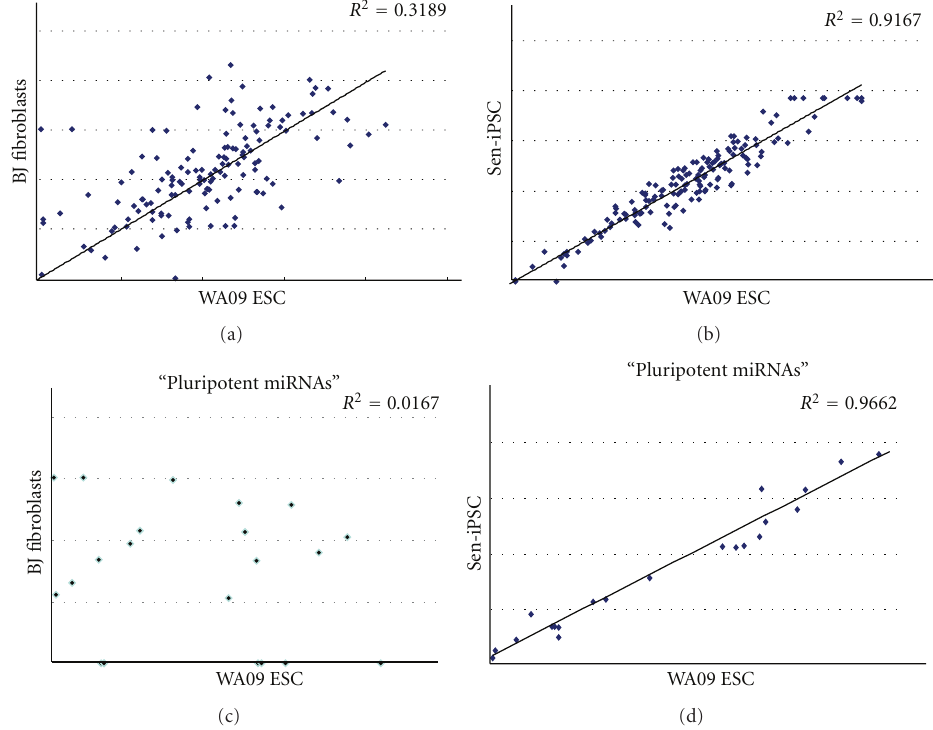
Figure 5: ((a) and (b)) Scatter plots comparing microRNA expression profiles using the TaqMan Human MicroRNA Array of BJ fibroblasts, iPSCs generated with the Sendai virus vector (Sen-iPSC), and the WA09 human embryonic stem cell (hESC) line. ((c) and (d)) Scatter plots comparing “pluripotent” microRNA expression